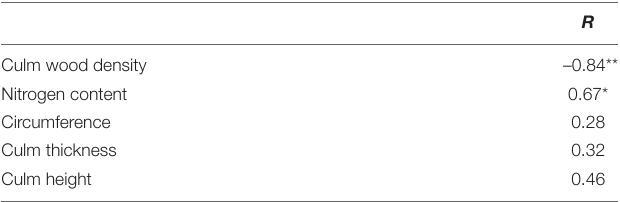
TABLE 2 | Anatomical and morphological factors in relation to culm respiration rates of all